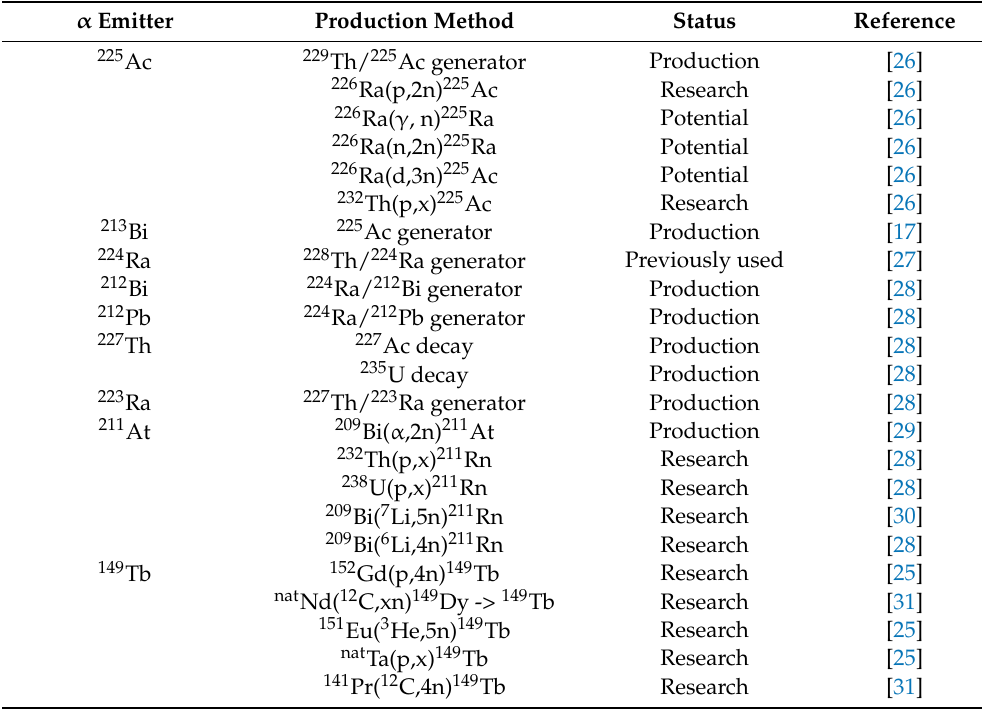
Table 3. Current and anticipated production methods for therapeutic alpha emitter